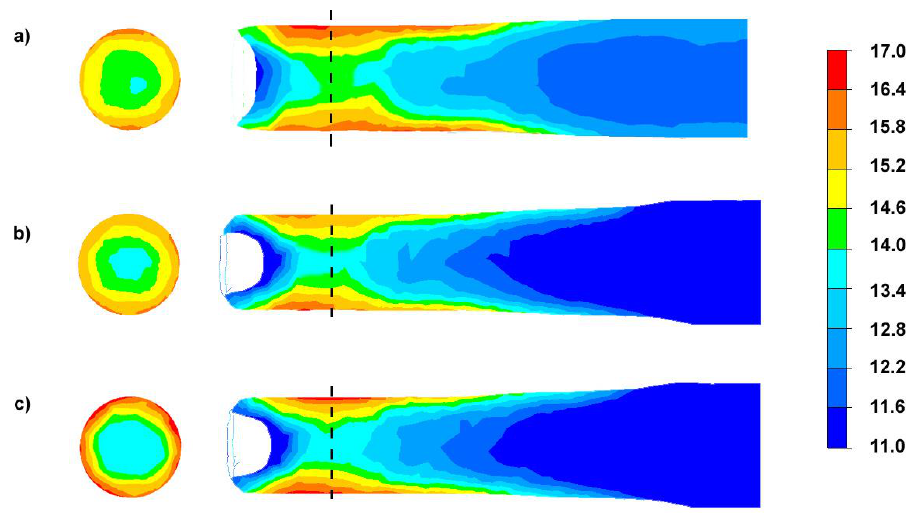
Figure 4. The effective strain distribution for the RSR process of bars from AZ31 alloy: ( a ) Variant I, ( b ) Variant II, ( c ) Variant III.